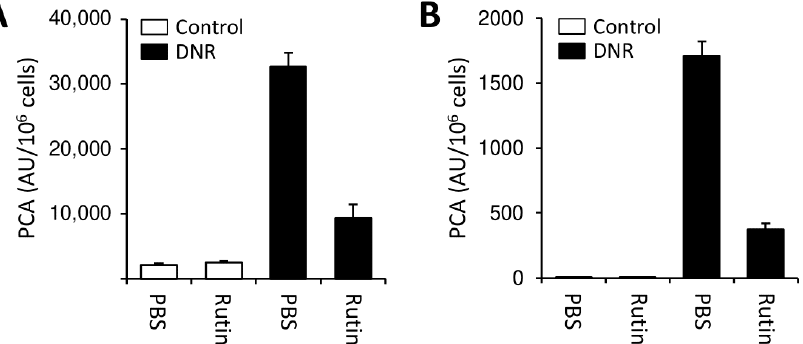
Figure 6. Effect of rutin on DNR-induced TF activation in PBMCs from AML patients. ( A , B ) Whole- blood PBMCs were isolated from two patients with newly diagnosed AML and incubated with 1 µ M DNR in the presence or absence of 100 µ M rutin for 24 h at 37 ◦ C. Cells were washed and analyzed for PCA by single-stage clotting assay. Results are presented as mean ± SD of triplicate meas- urements.